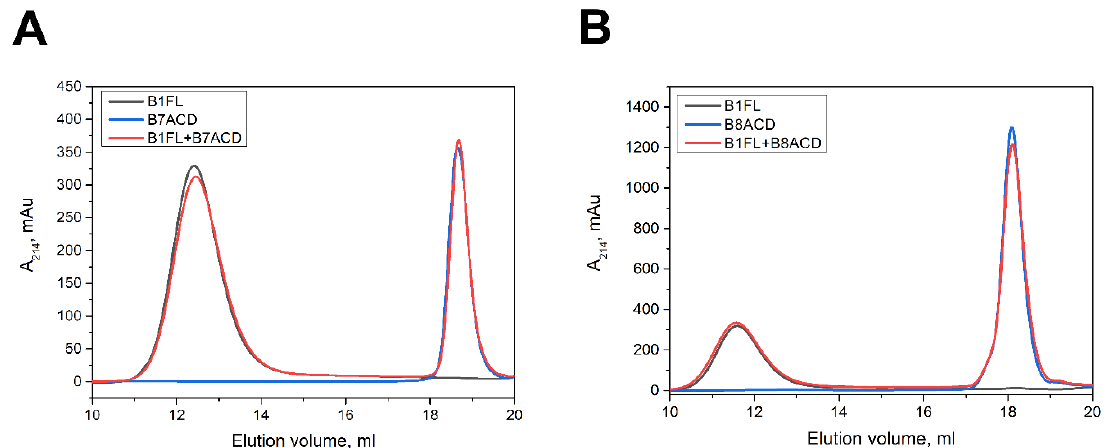
Figure 6. Interactions of ( A ) B7ACD and ( B ) B8ACD with HspB1. Elution profiles of full-length (FL) HspB1 (black lines), B7ACD and B8ACD (blue lines), and an equimolar mixture of HspB1 and the corresponding α -crystallin domains (red line) on a Superdex 200 Increase 10/300 column.